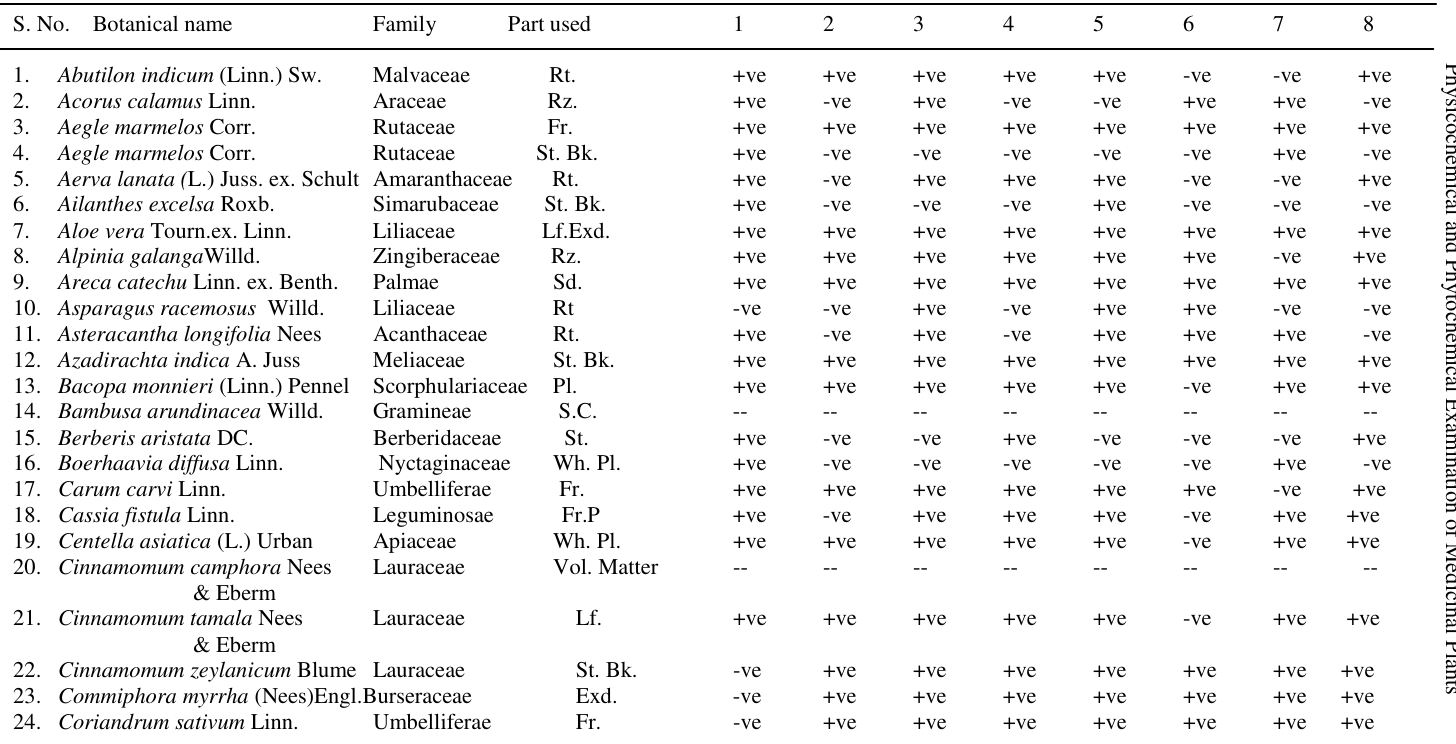
Table – 2. Results of phytochemical